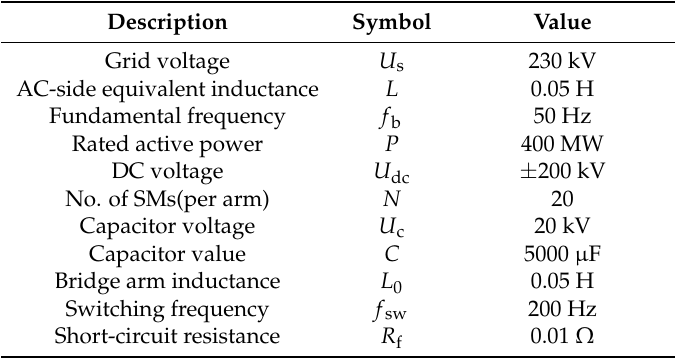
Table 1. The system parameters of the modular multilevel converter based high voltage direct current (MMC-HVDC).